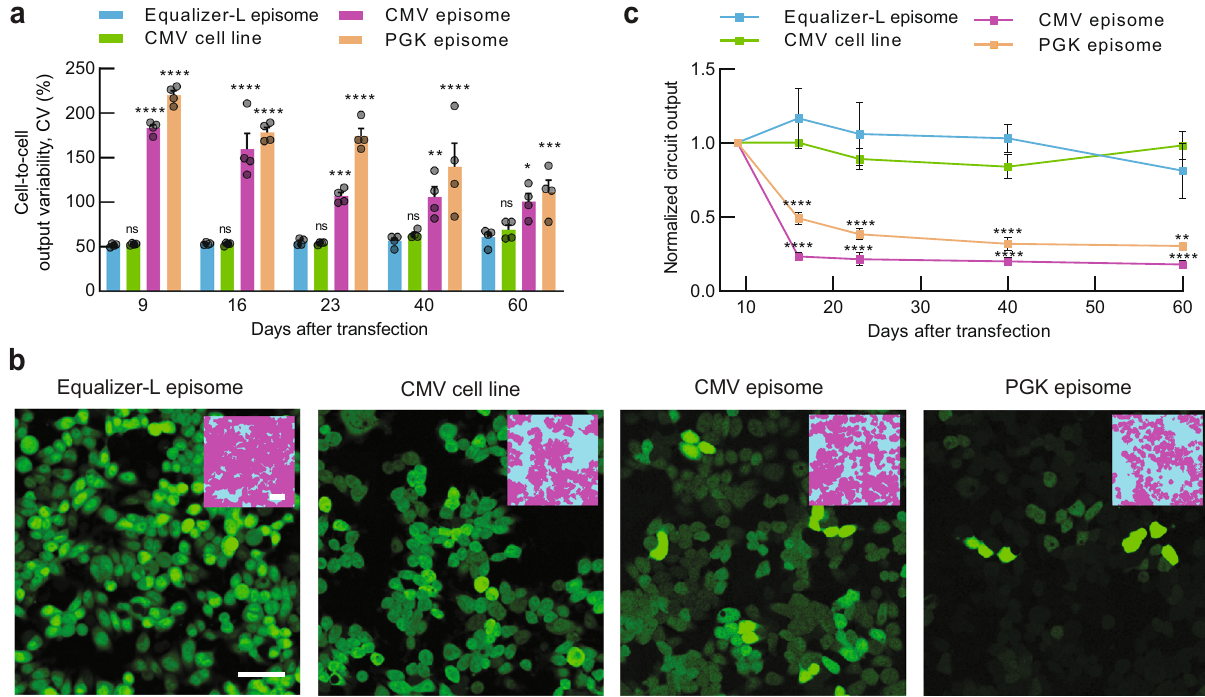
Fig. 6 A replicating variant of Equalizer-L enables the development of extra-chromosomal cell lines that have stable gene expression with low cell-to- cell variation. a Over the course of >8 weeks, the Equalizer-L episome produced similar cell-to-cell variation as a chromosomally integrated CMV cassette (CMV cell line) and lower variation than episomes with unregulated promoters. HEK293 cells were used. For all experiments a – c , Equalizer-L was induced with 1-ng/mL doxycycyline. The error bars represent SEM. n = 4 independent trials. Tukey ’ s multiple comparison test was used to compare the Equalizer-L episome with the other conditions. ns not signi fi cant; * p < 0.05; ** p < 0.01; *** p < 0.001; **** p < 0.0001. b Representative images of HEK293 cells expressing EGFP from episomes or the chromosome at 23 days post transfection. Each image is displayed with a linear lookup table with the minimum set to 0 and the maximum set to the sum of the mean intensity value and three standard deviations (see Methods). This approach enables a qualitative comparison of the cell-to-cell expression variability despite large differences in mean circuit output. Insets, binary masks to help identify regions of the images that correspond to cells (magenta region). Scale bar, 50 μ m. See Supplementary Fig. 18 for images acquired on other days. c The circuit output levels from the Equalizer-L episome were stable for >50 days, whereas episomes with unregulated promoters displayed pronounced declines. Each circuit ’ s mean output levels were normalized to levels at 9 days post transfection. Induction, sample sizes, error bars, and statistical tests are as in ( a ). Source data are provided as a Source Data fi